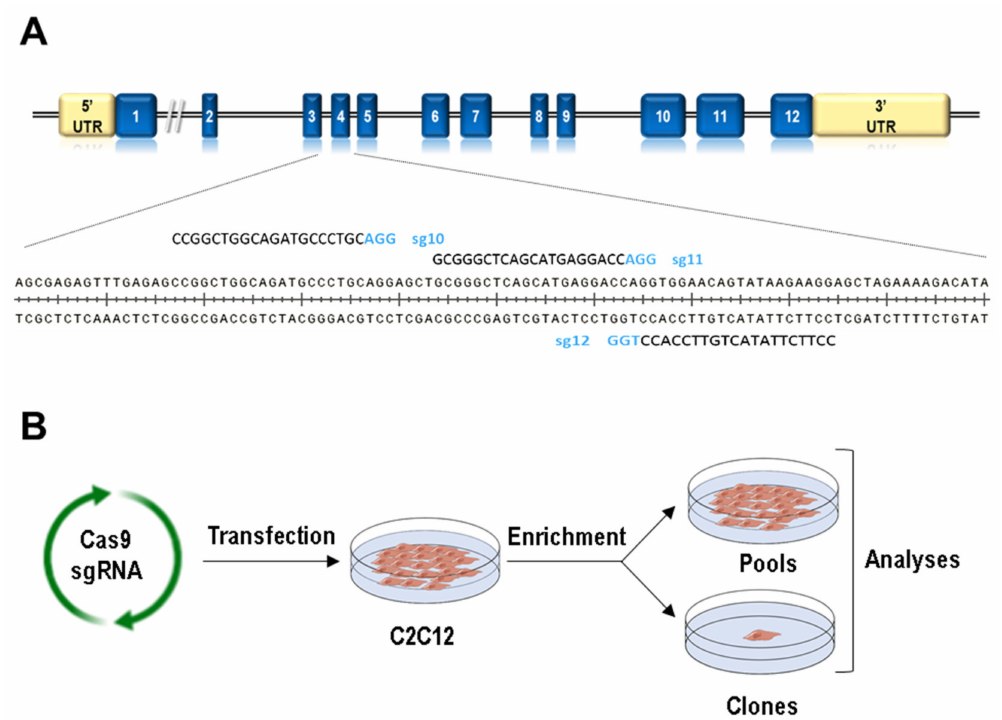
Figure 1. Generation of Lamin A / C gene ( Lmna ) exon 4 mutations using CRISPR / Cas technology. ( A ) Scheme for exon 4 Lmna sgRNA localization. ( B ) Work-flow followed for the generation of C2C12 cells carrying mutations in Lmna exon